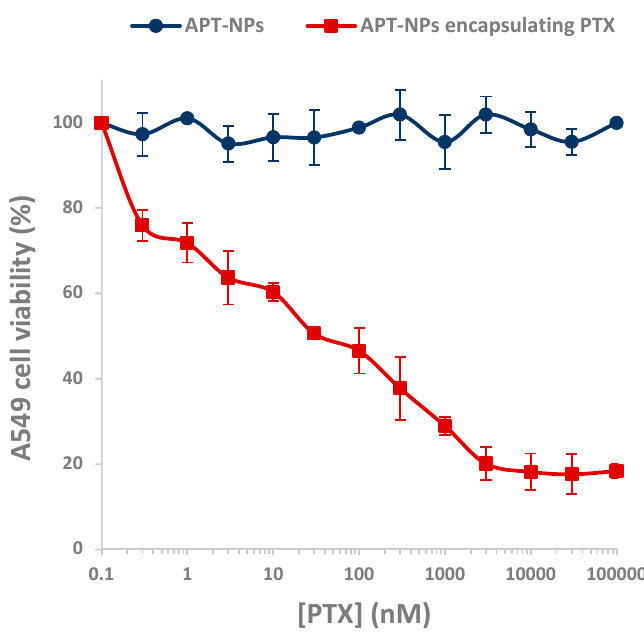
Figure 6. The impact of drug-free APT-NPs vs. APT-NPs encapsulating PTX on the viability of target A549 cells.